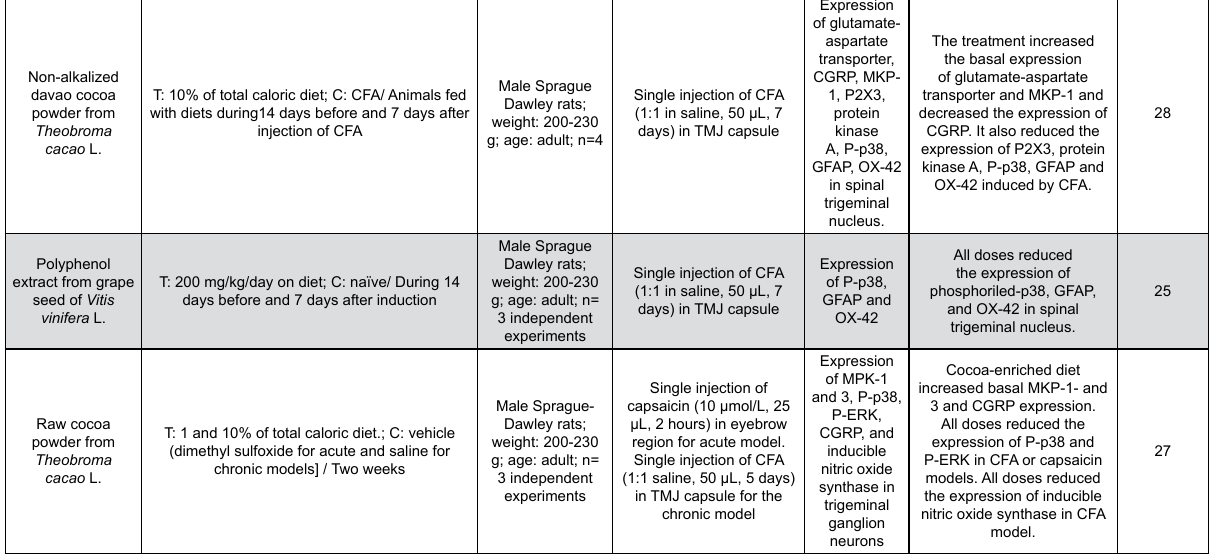
Figure 3- Characteristics of the studies included